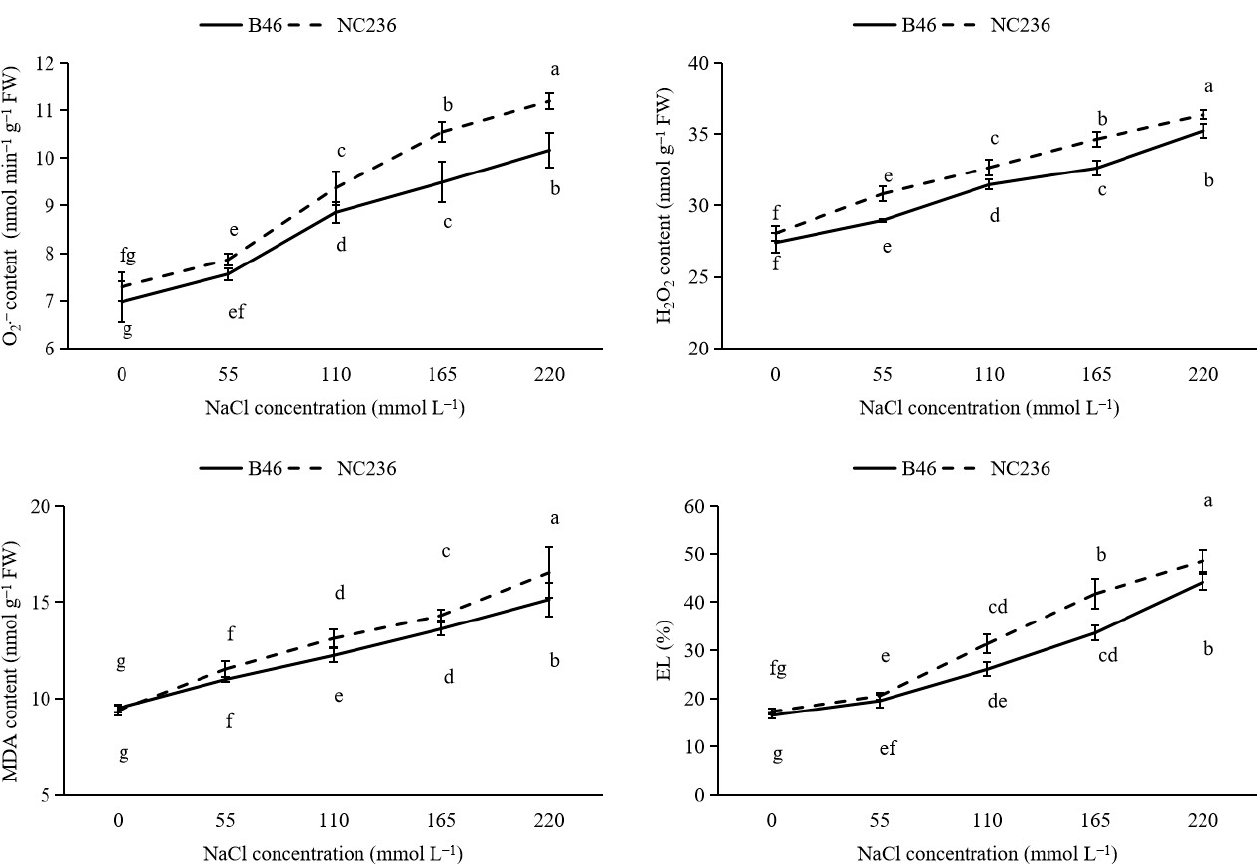
Figure 1. Effect of salt stress on the contents of O 2 − , H 2 O 2 , MDA, and EL value in maize leaves. Data are expressed as mean ± standard deviation. Different letters within the same column indicate significant difference at the 5%